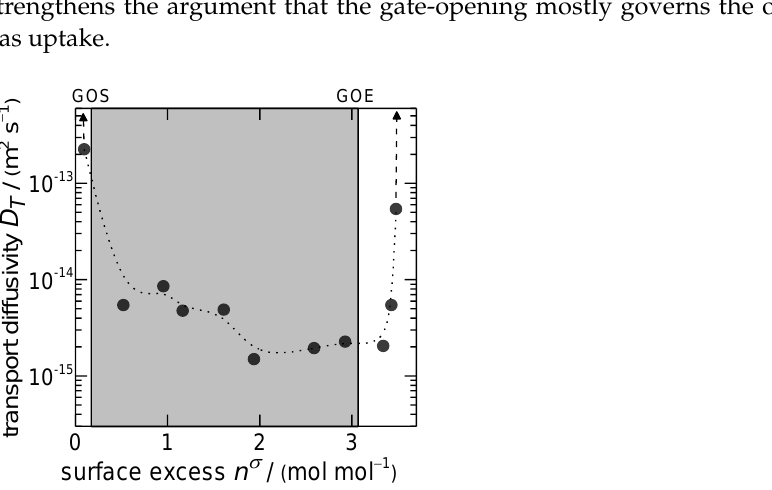
Figure 4. Transport diffusivities of n -butane on 1 in dependence of the loading. The grey area marks the loading range between gate-opening start ( GOS ) and gate-opening end ( GOE ). The arrows indi- cate much higher diffusivities in the regions of very low and very high pressures, which were not measurable under the experimental conditions.